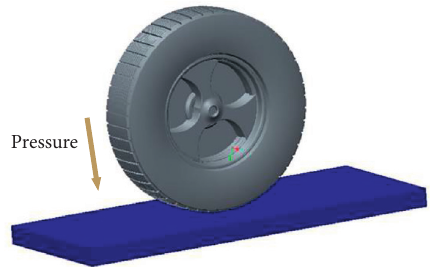
Figure 11: Vehicle-road contacting